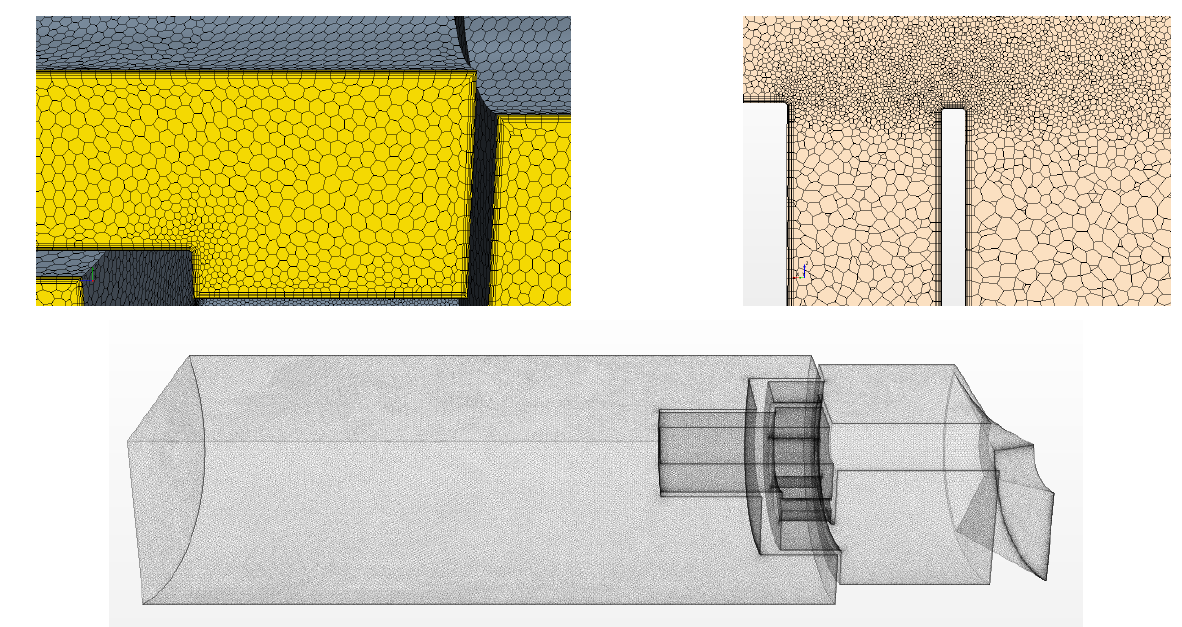
Figure 2. Mesh. ( upper left ) Periodic mesh; ( upper right ) refined core; ( bottom ) entire mesh.